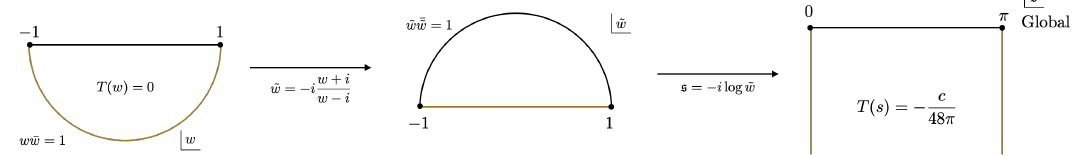
Figure 8. The conformal transformations relating the Kruskal and global vacuums. In this figure the Kruskal-Szekeres coordinate is denoted by w rather than w